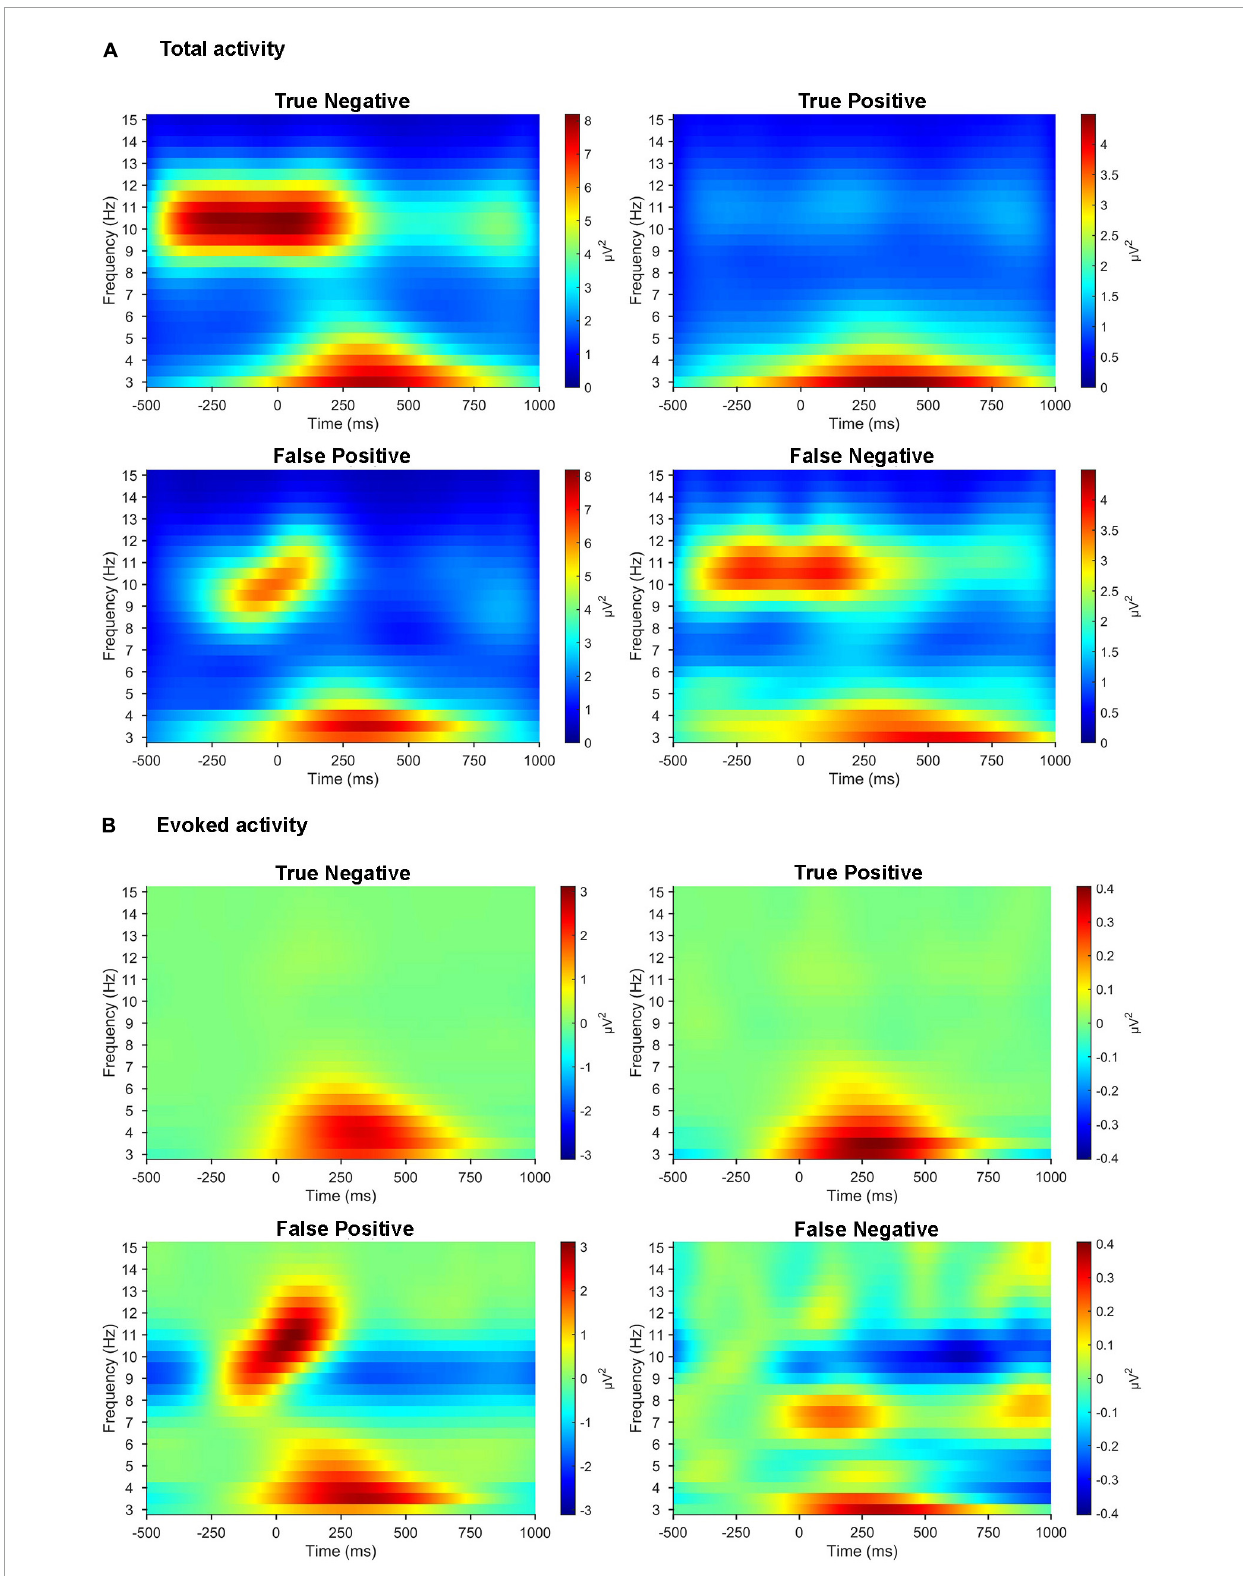
FIGURE7 Time-frequency representations of misclassified EEG trials compared with those correctly classified. (A) Time-frequency representations of total activity averaged across three parietal electrodes (Pz, P3, and P4) for the target stimuli in the active oddball task. (B) Time-frequency representations of evoked activity averaged across the same three parietal electrodes for the target stimuli in the active oddball task. All the plots are computed across all the EEG trials (from a sample pair of healthy/patient subjects) collected individually for true positive, false positive, true negative, and false